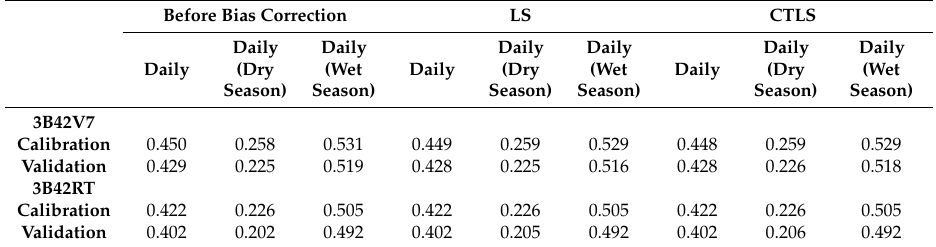
Table 12. Average CSI score’s performance of calibration and validation for CTLS with TMPA 34B42V7 and TMPA 3B42RT for daily, daily (dry season), and daily (wet season). Before Bias Correction